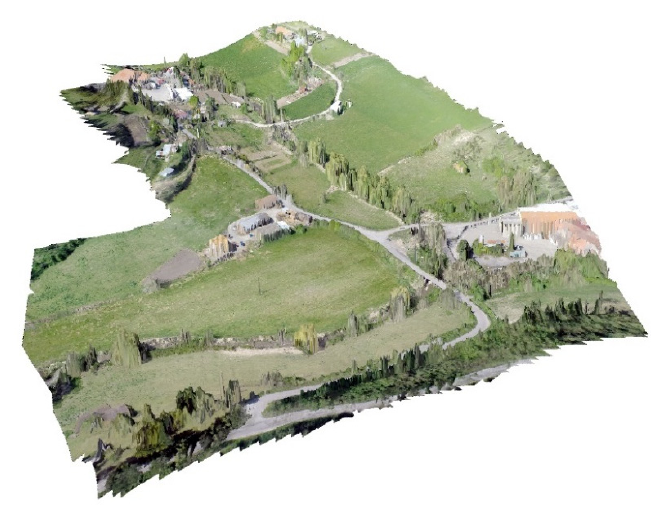
Figure 3. 3D scene of the Drone-derived Digital Surface Model (DSM) and orthophoto.